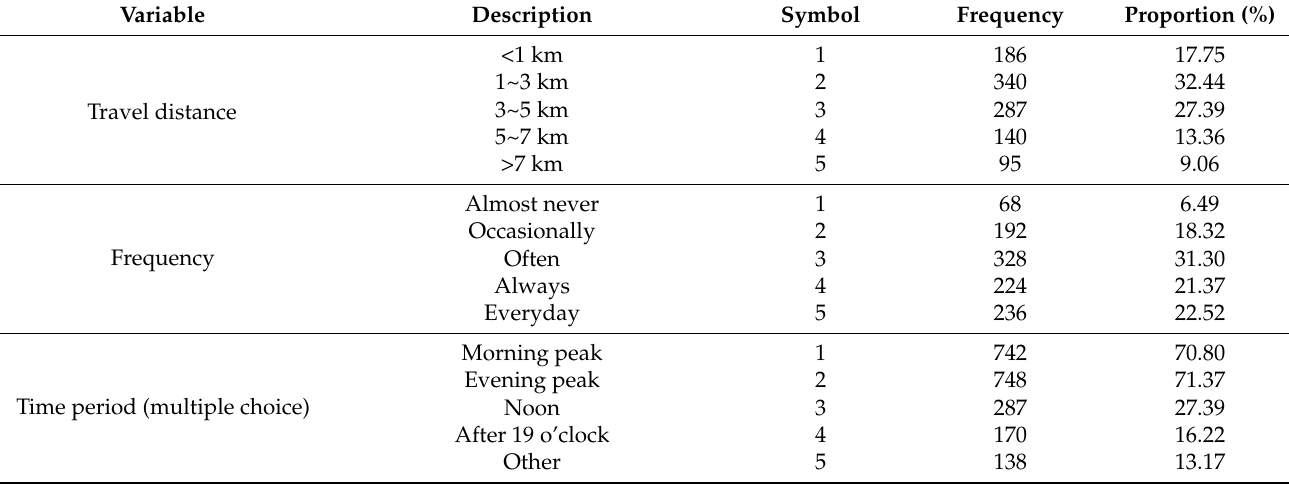
Table 2. Descriptive statistics for travel